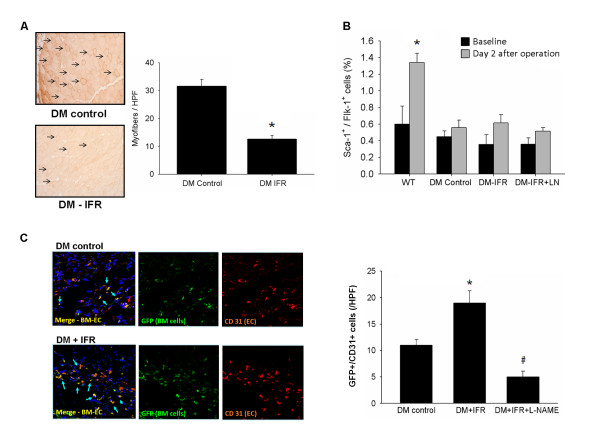
 Effects of IFR radiation on oxidative stress, EPC mobilization after hindlimb ischemia and tissue homing in STZ-induced diabetic mice. (A) Effect of IFR on oxidative stress in ischemic muscles of STZ-induced diabetic mice. Nitrotyrosine (n = 4 per group) immunostaining of ischemic muscles extracted on day 21 in control (vehicle), and in mice that had received IFR radiation. (*p < 0.05 compared with DM-control) (B) EPCs (defined as Sca-1+/Flk-1+ cells) mobilization after tissue ischemia was determined by flow cytometry in STZ-induced diabetic mice given the vehicle, IFR or IFR + L-NAME. (*p < 0.05 compared with WT-baseline; n = 6 per group) (C) STZ-induced diabetes was created in FVB mice that received eGFP mouse bone marrow cells. By immunofluorescence staining, STZ-induced diabetic mice in IFR group had more GFP+/CD31+ double-positive cells in ischemic muscle than those in the vehicle group. (*p < 0.05 compared with DM-control; #p < 0.05 compared with DM-FIR; n = 6).